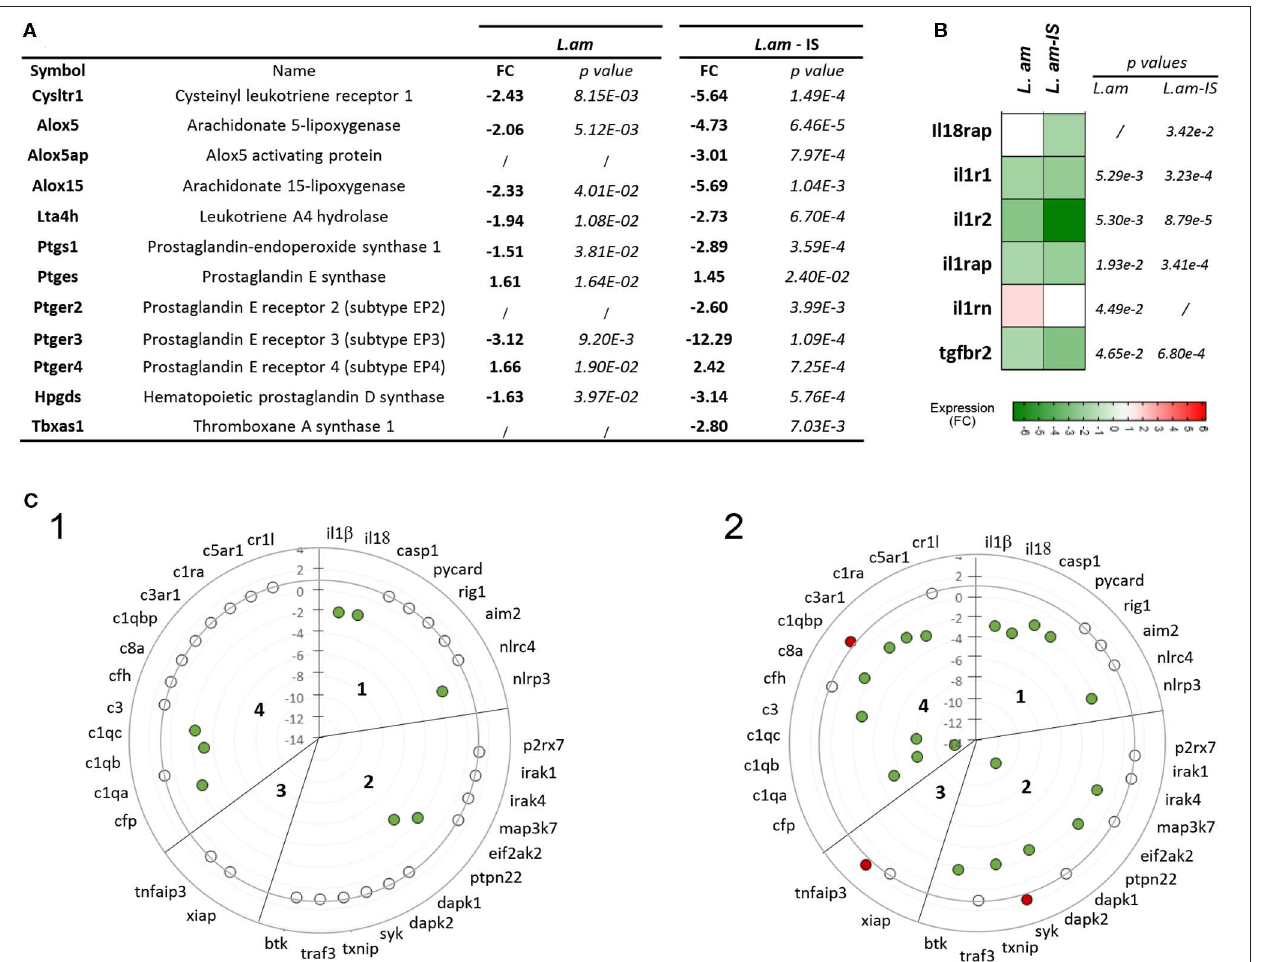
FIGURE 5 | Induction of an anti-inflammatory expression profile in L. am-infected BMDCs. Transcriptional modulation observed in the microarray analysis are displayed as mean fold change values calculated using uninfected sorted DCs as calibrator. (A) List of differentially expressed genes associated to eicosanoid production. Linear fold changes and p -values are indicated for L. am and L. am -IS sorted DCs. (B) Heatmap of transcriptional modulations observed for cytokine receptor genes. (C) Transcriptional profiling of genes related to NLRP3 inflammasome priming and activation pathways. Radar plots displaying the modulation of gene expression in sorted DCs infected with non-opsonized ( L. am, panel 1) and Ab-opsonized ( L. am -IS, panel 2) Ds Red2-transgenic L. am amastigotes. The sub-sections correspond to inflammasome-related cytokines and inflammasome components (section 1), NLRP3/ASC activators (section 2), NLRP3 inhibitors (section 3), and components of the complement system (section 4). Unmodulated transcripts are indicated by open dots, whereas up-modulated and down-modulated transcripts are indicated by red and green dots,